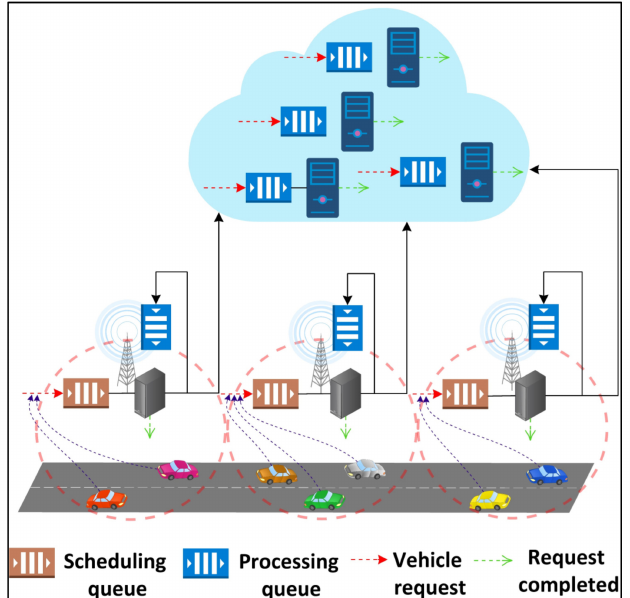
Figure 2. Request offloading and execution using scheduling and processing